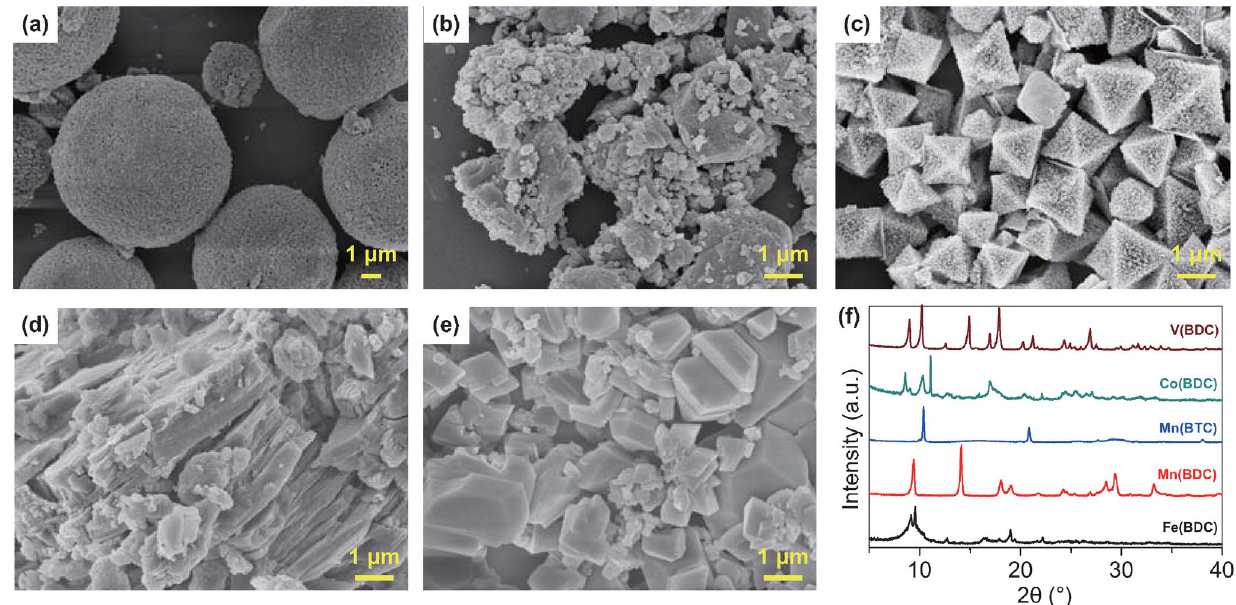
Fig. 1 SEM images of the synthesized MOF materials: a Mn(BTC), b Mn(BDC), c Fe(BDC), d Co(BDC), and e V(BDC), f XRD patterns of the